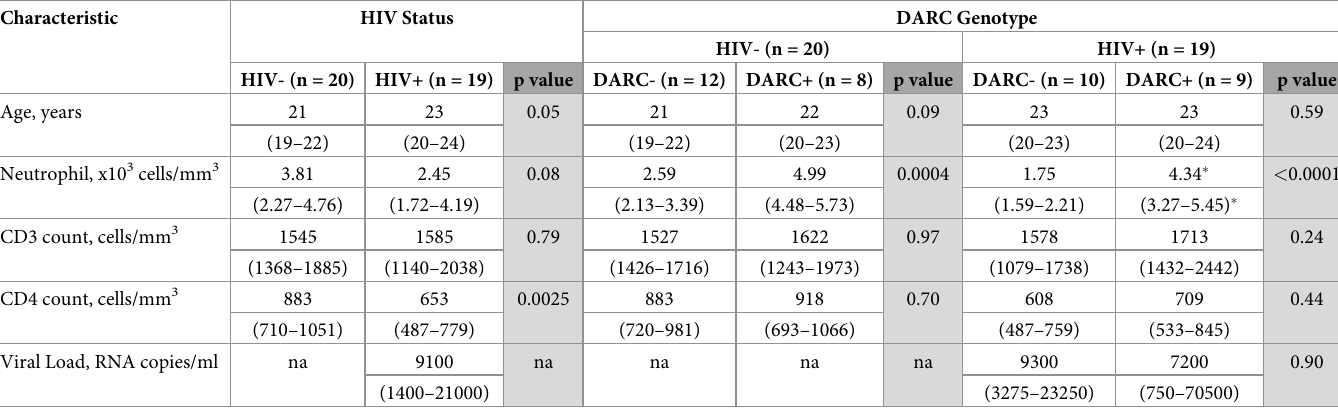
Data is represented as median (IQR). � ANC median and IQR were calculated from 8 participants (ANC was not available for 1 participant). All HIV+ participants were antiretroviral therapy na ï ve. Abbreviations: DARC, Duffy Antigen Receptor for Chemokines; ANC, Absolute Neutrophil Count; IQR, Interquartile range; n, number; na, not applicable. Female participants: n = 38, Male participants: n =